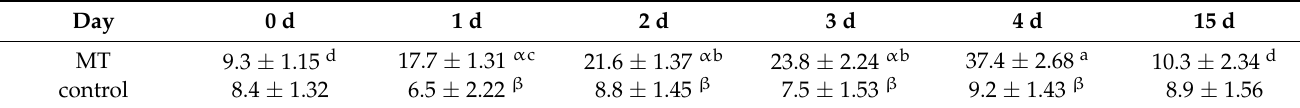
Table 2. Change in the blood melatonin levels in dairy cows (ng/mL).